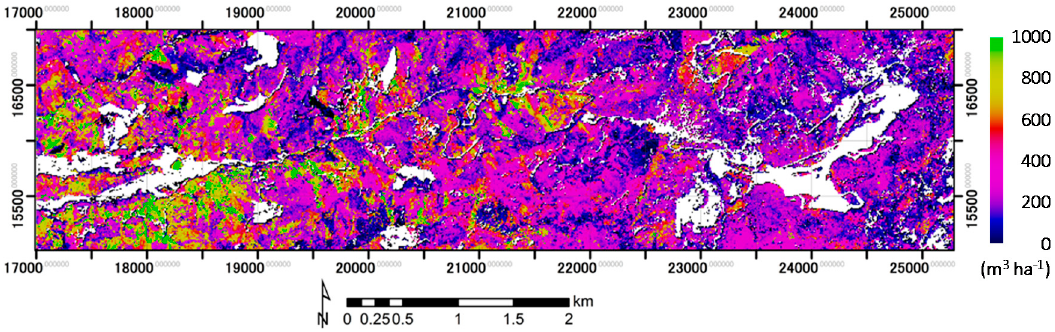
Figure 7. Distribution of SV using Equations (5) and (7). The white areas are non-forested.